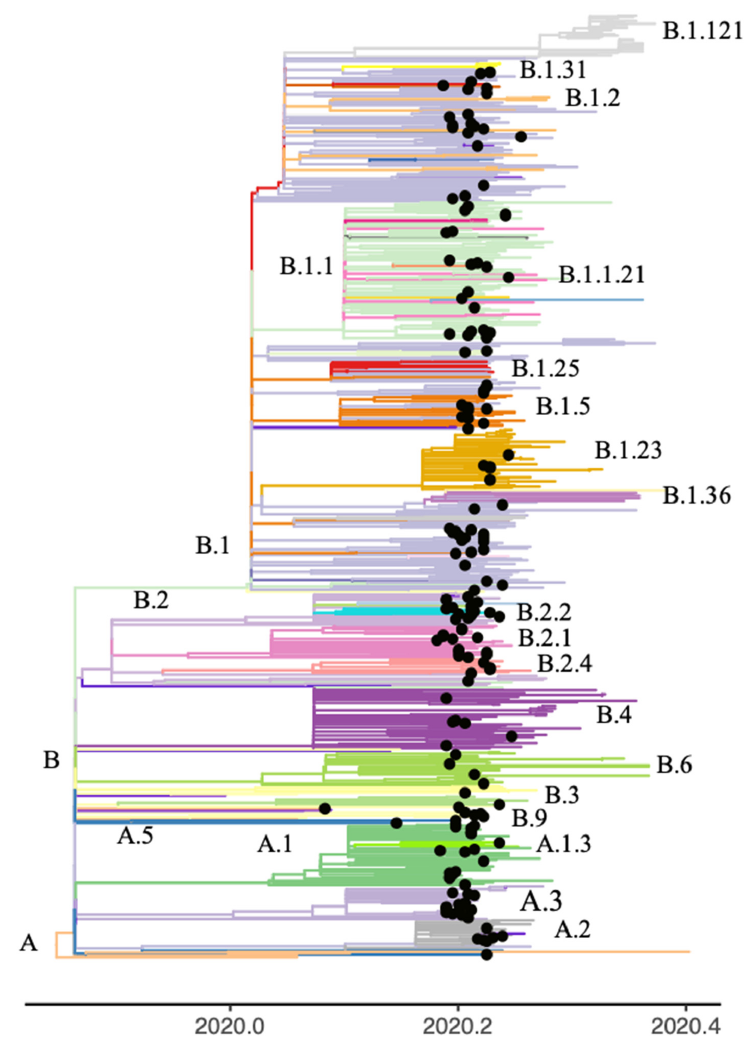
Figure 3. Phylogenetic tree of the severe acute respiratory syndrome coronavirus 2 (SARS-CoV-2) genomic sequences collected in the State of Victoria, Australia. The clusters are colored according to Pangolin annotation. The black tips represent the consensus sequences derived from the next-generation sequencing (NGS) data.